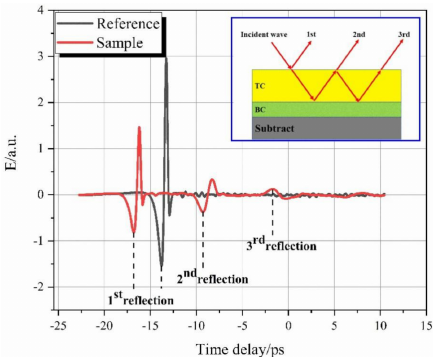
Figure 2. Schematic diagram of terahertz wave reflection when measuring TBCs.